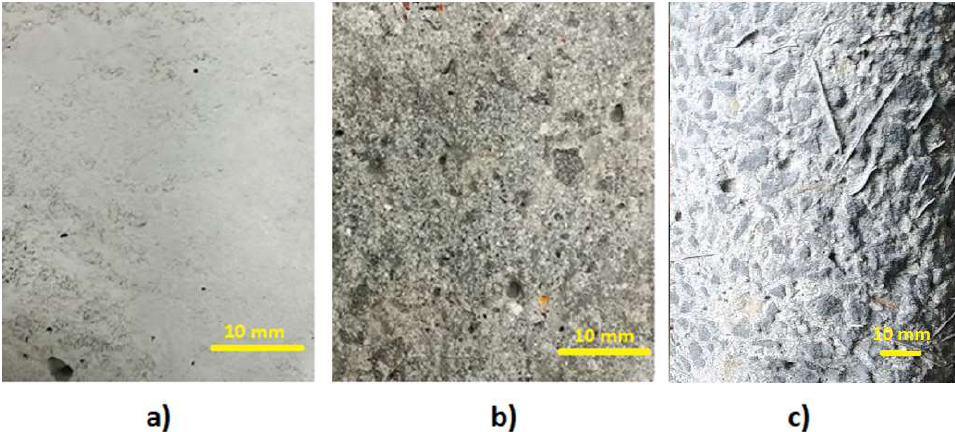
Figure 4. Unprepared surface ( a ), grinded surface ( b ) and sanded surface ( c ).